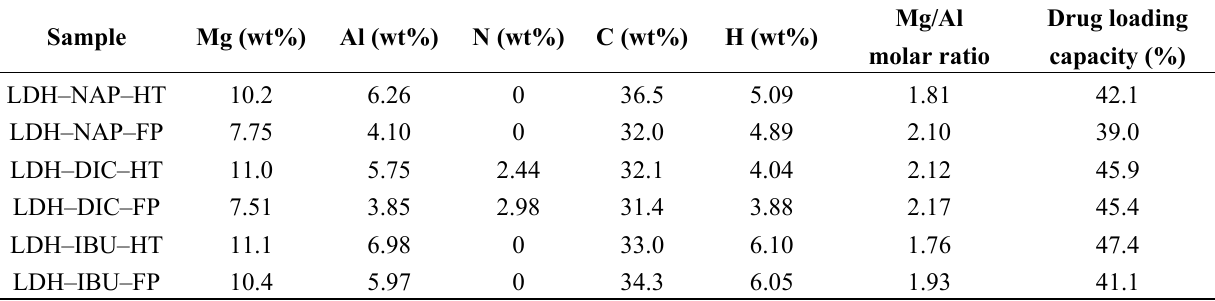
Table 3. Ratios of metal elements, drug loading capacity and predicted chemical structures of LDH–NAP–HT/FP, LDH–DIC–HT/FP and